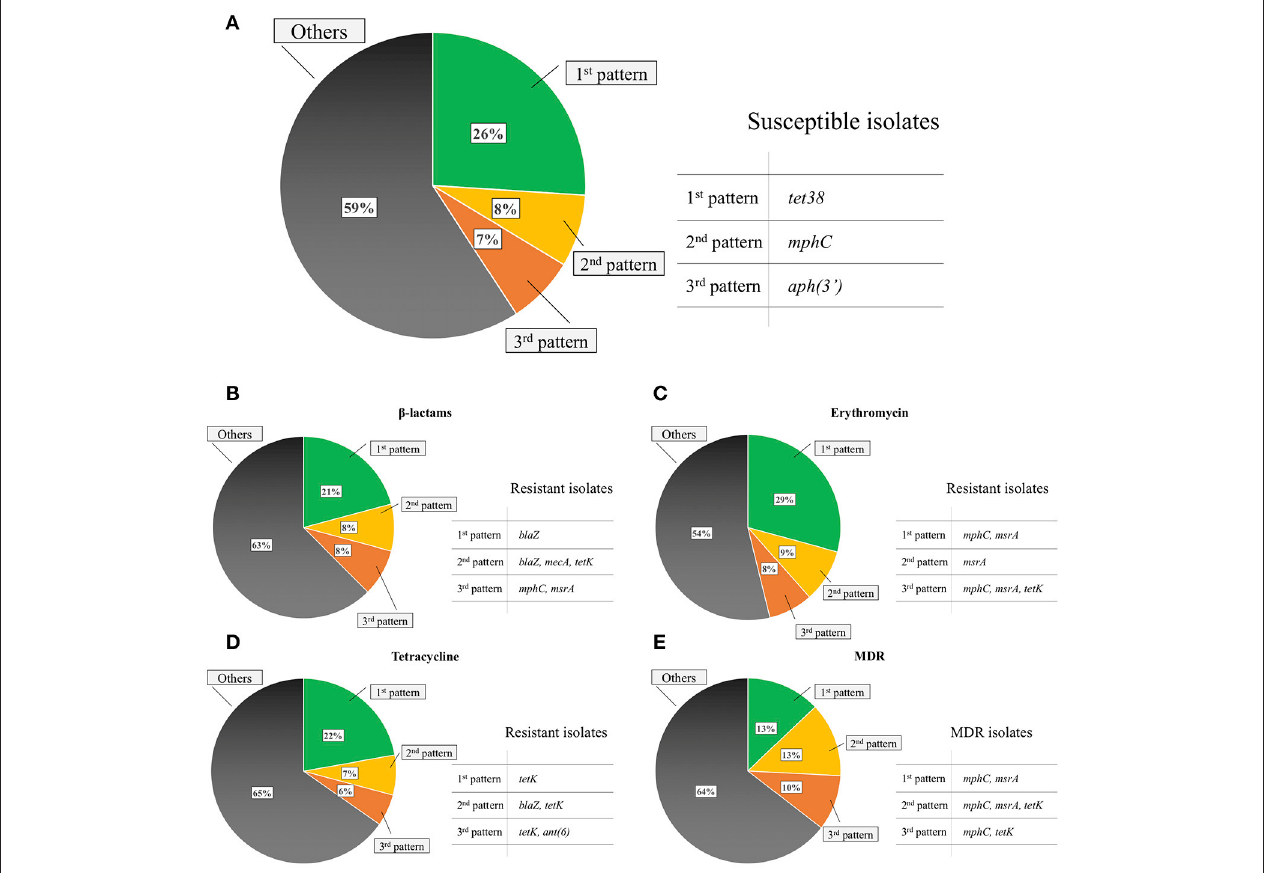
FIGURE 2 | Common gene patterns in susceptible non- aureus staphylococci isolates (A) , isolates resistant to β -lactams (B) , erythromycin (C) , tetracycline (D) , and in multidrug resistant (MDR) isolates (E) when excluding any MDR efflux pumps and antimicrobial resistance-associated residues in the deduced amino acid sequence of any gene